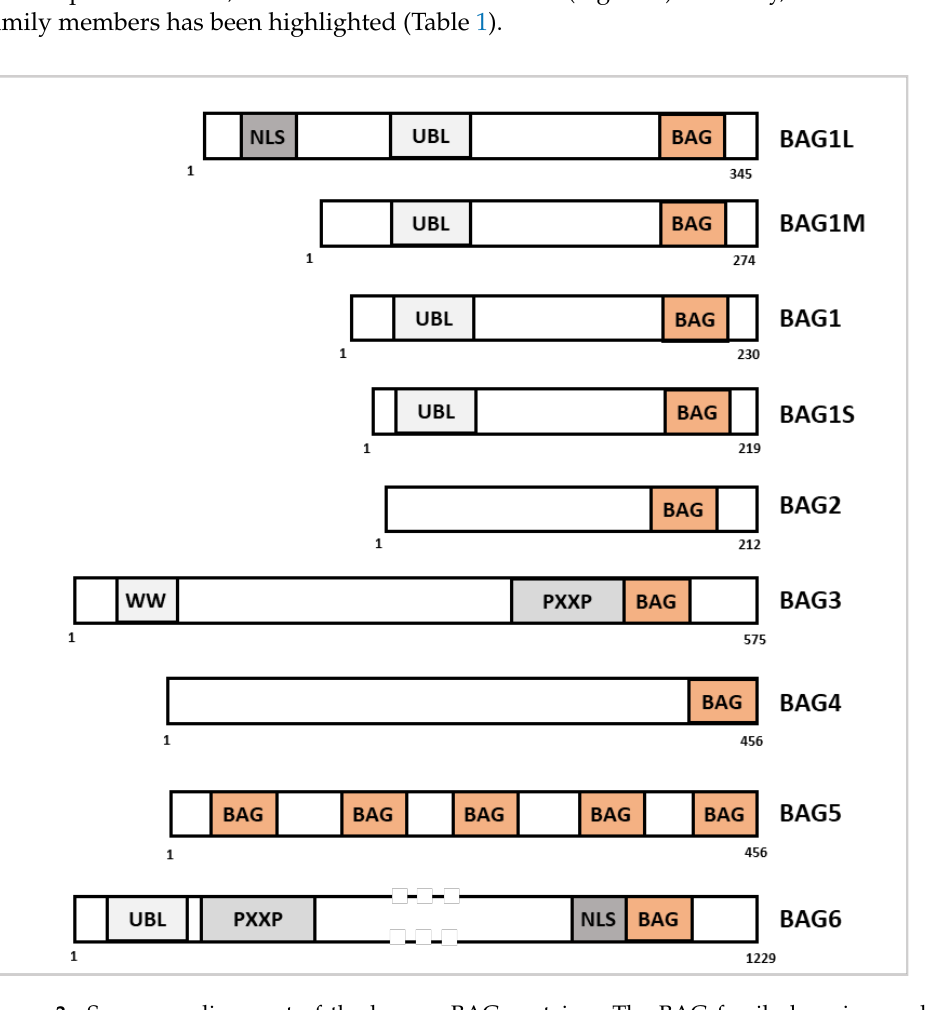
Figure 3. Sequence alignment of the human BAG proteins. The BAG family has six members (BAG1 to BAG6). Each family member contains a conserved BAG domain (orange) in its C-terminal region, except BAG5, which has five BAG domains. Four BAG1 isoforms, generated by alternative splicing, have been identified (BAG1L, BAG1M, BAG1, BAG1S). In addition to the BAG domain, BAG family members contain specific domains that are mainly involved in protein – protein interaction (UBL, PXXP). BAG1L and BAG6 also contain a nuclear localization signal (NLS) that allows their nucleo- cytoplasmic shuttling.